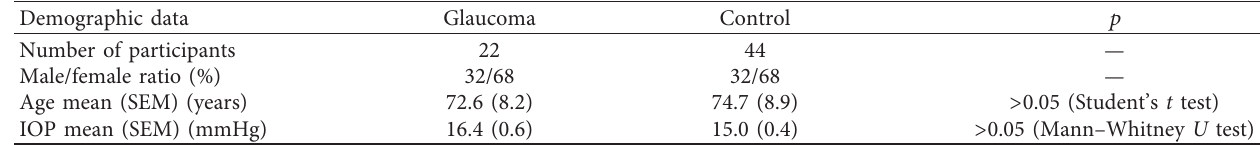
Table 1: Demographic data of participants in control and glaucoma groups.